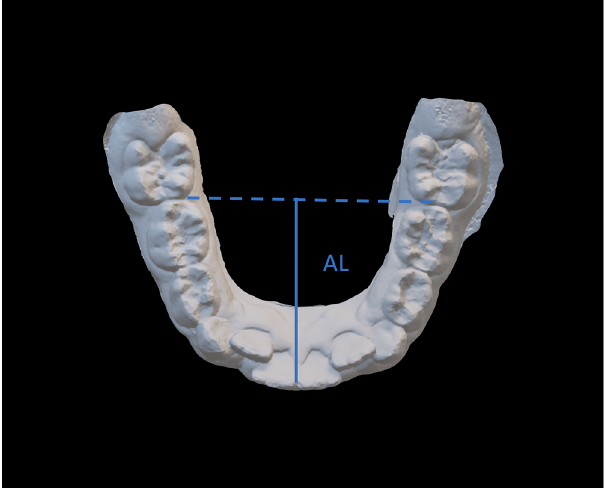
Figure 4. Arch length (AL).